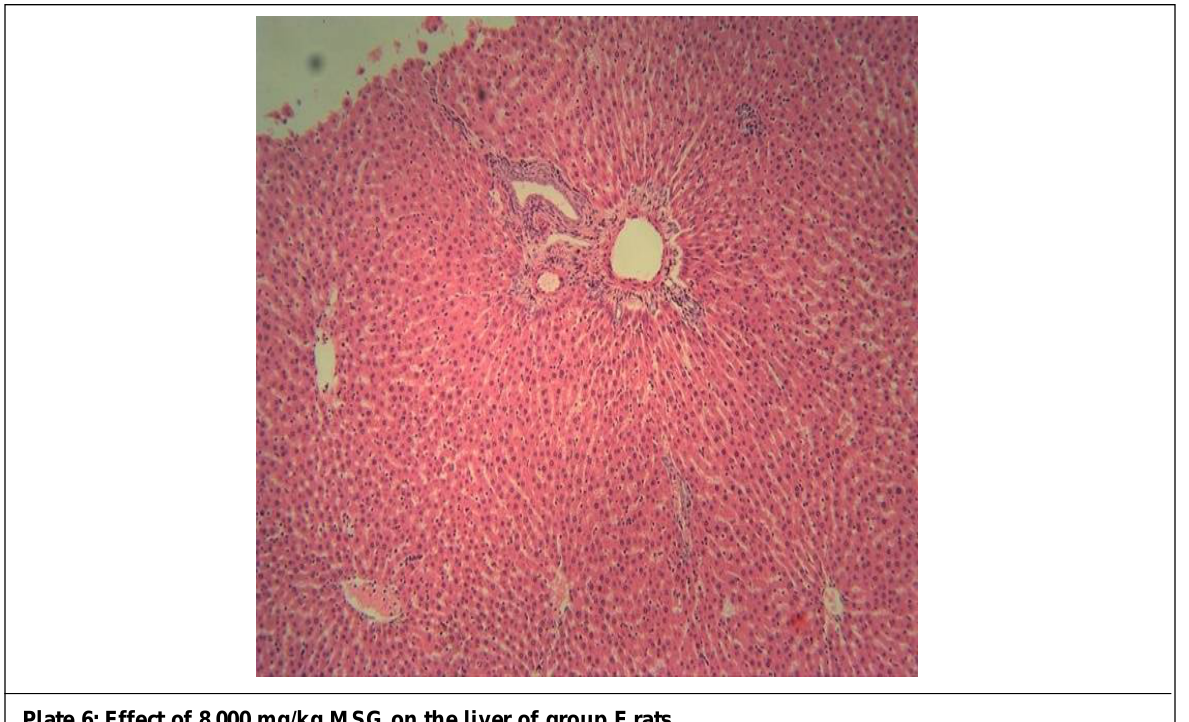
Photomicrographs of the section of the liver of group F rats administered with 8,000 mg/kg MSG showed loss of normal hepatocytes architecture, nuclei of varying sizes and shapes, loss of sinusoidal spaces, presence of mild inflammatory cells and dilated central vein (Mg X400).